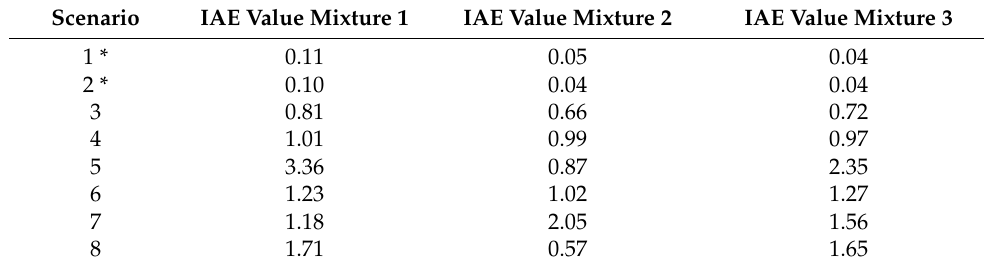
Figure 9. Simulated dynamic results on product qualities with adapted reboiler control loop for different scenarios: ( a ) Scenario 1 Mixture 1, ( b ) Scenario 2 Mixture 1, ( c ) Scenario 1 Mixture 2, ( d ) Scenario 2 Mixture 2, ( e ) Scenario 1 Mixture 3, and ( f ) Scenario 2 Mixture 3. Table 10. IAE results displayed as the sum of all products for mixture